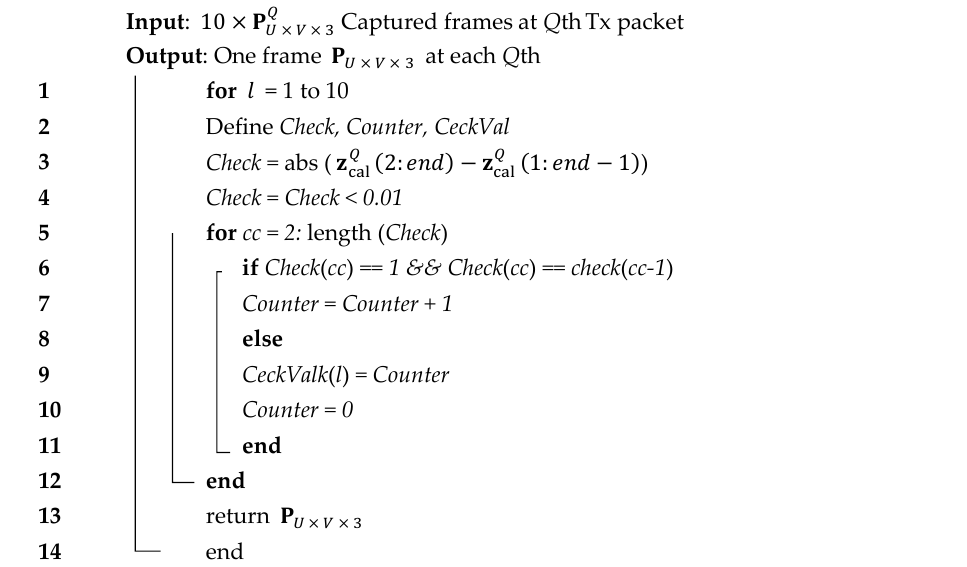
Sensors 2021 , 21 , x FOR PEER REVIEW 10 of 17 Figure 5. An example of the received Q th Tx packet signal at a T exp of 2 ms: ( a ) without DC gain normalization, and ( b ) with normalization. Algorithm 2 Find the frame with full packet inclusion (i.e., includes both pre- and post-ambles)